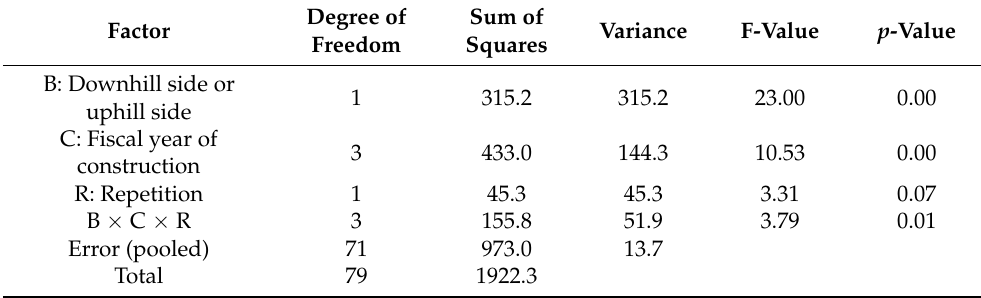
Table 5. ANOVA table of in-situ CBR in Site 2.